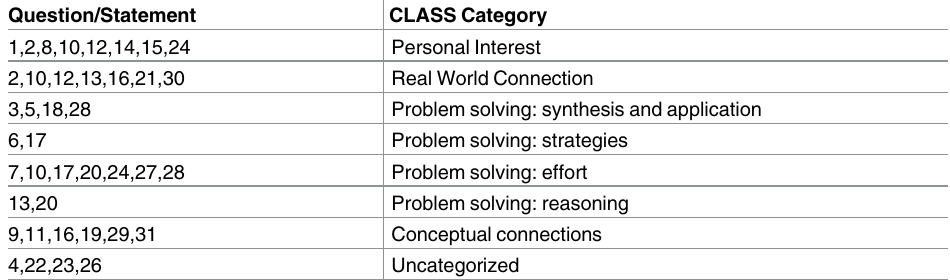
Table 2. Classification of the three learning objectives * as addressed by questions/statements on the CLASS survey.